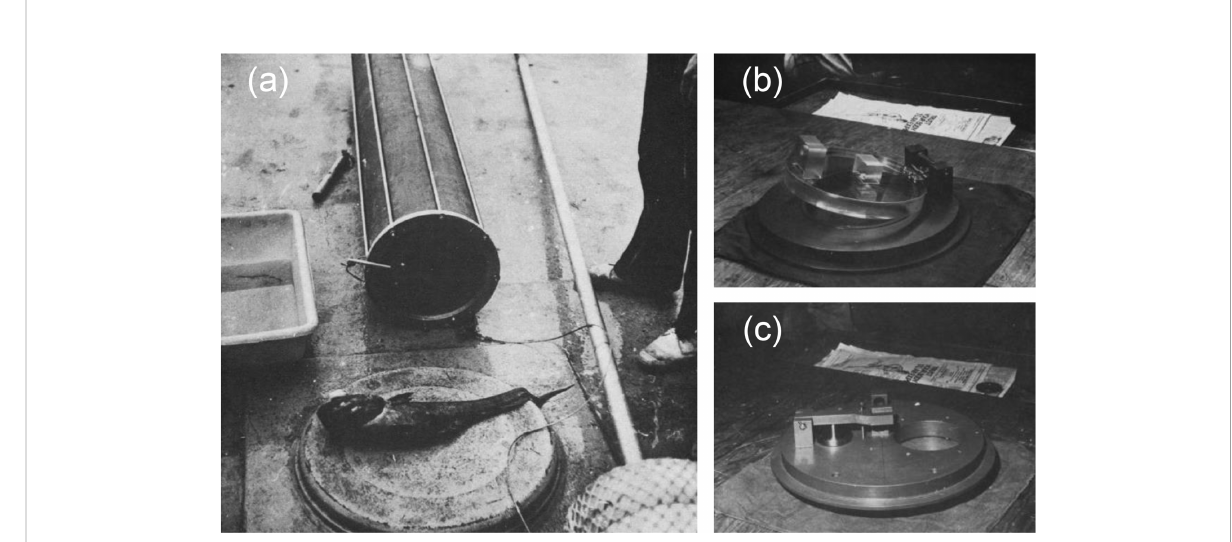
FIGURE 2 Photos of pressure fi sh trap. (A) Fish trap with grenadier or rattail about 60cm long caught in trap at depth of 1200m. (B) Pressure fi sh trap, internal door bottom, lower end plate. (C) Pressure fi sh trap, upper end plate with access port and air vent valve.) (adapted from Brown,